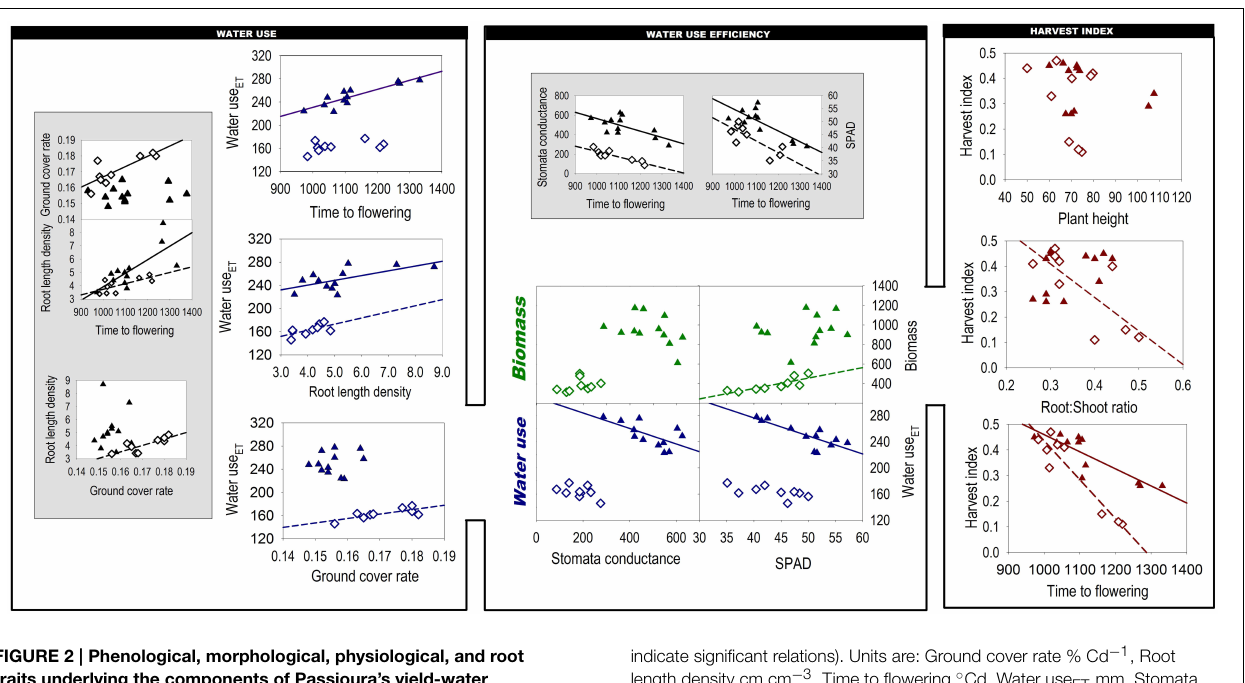
indicate significant relations). Units are: Ground cover rate % Cd − 1 , Root length density cm cm − 3 , Time to flowering ◦ Cd, Water use ET mm, Stomata conductance mmol m − 2 s − 1 , Biomass g m − 2 , SPAD dimensionless, Harvest index g g − 1 , Plant height cm, Root:Shoot ratio g g − 1